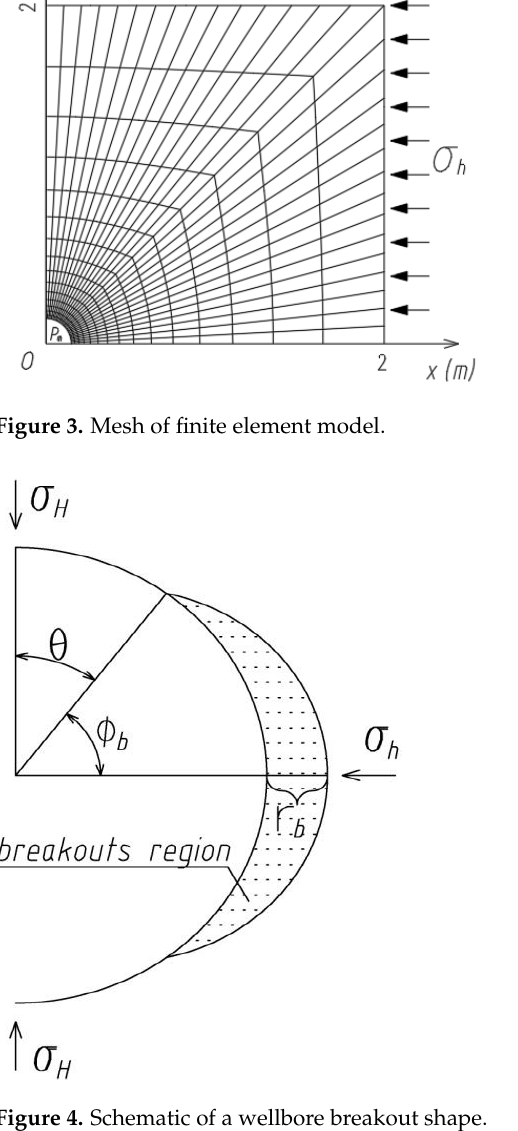
Table 1. Geometric and mechanical parameters.